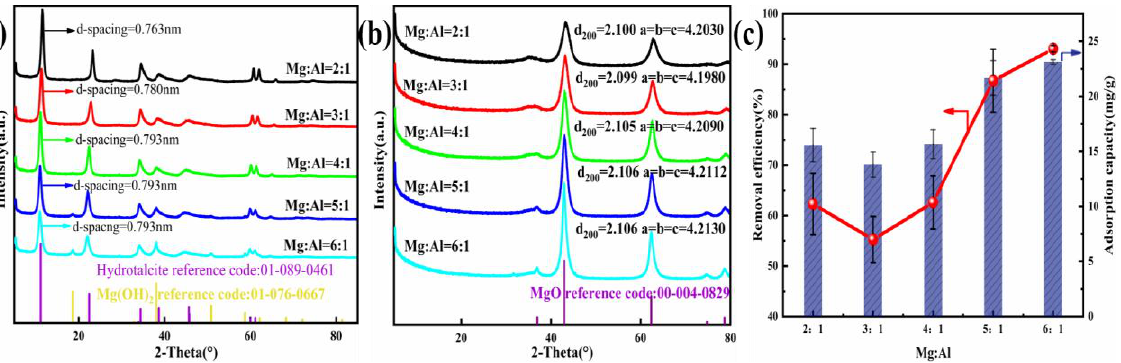
Figure 1. ( a ) XRD pattern of the precursor. ( b ) Diffractograms of the LDO materials. ( c ) Adsorption properties of the adsorbent with different M 2+ /M 3+ .